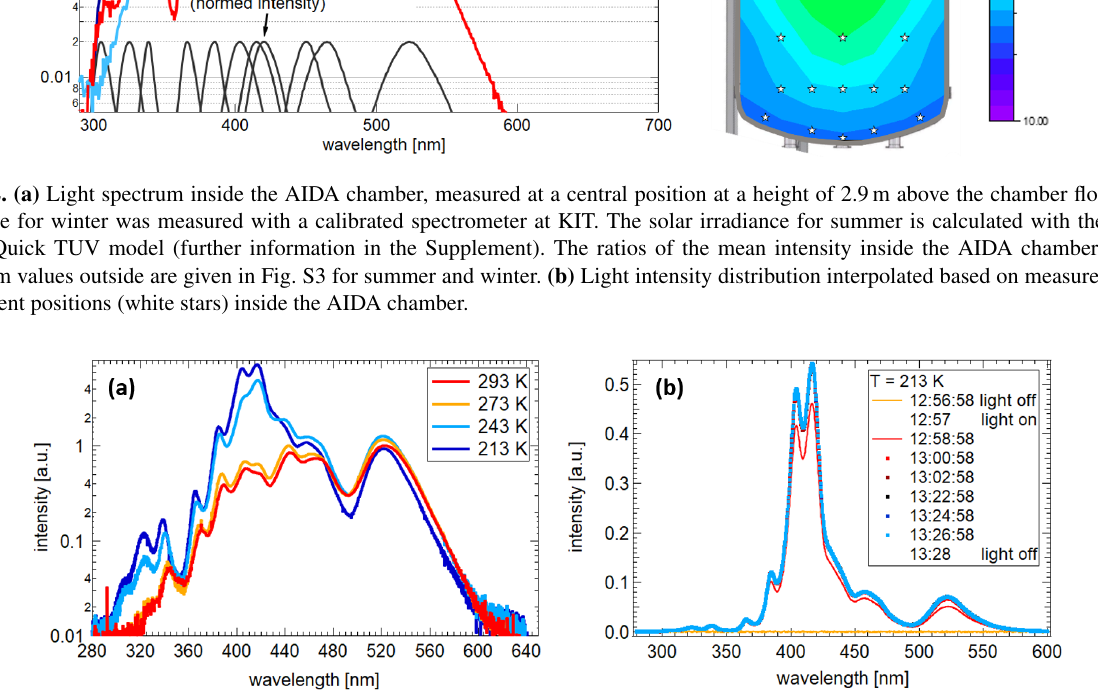
Figure 3. (a) Spectra taken with the UV-Vis spectrometer at the bottom of the chamber at four different temperatures. The electrical settings for the LEDs for each temperature are different. In addition to the emission changes in the LEDs due to the temperature variation, this leads to different spectral distributions for each temperature. (b) Spectra taken with the UV-Vis spectrometer at the bottom of the chamber over a time period of